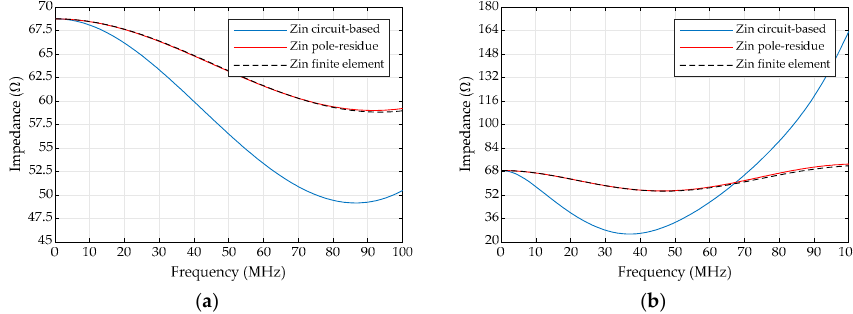
Figure 5. Impedance-frequency comparison of modelling techniques: ( a ) bus-spacer; and ( b ) 90° elbow. A close match between the pole-residue models and the finite element models implies a good fit in the frequency domain. The behaviour of the circuit-based elbow model differs significantly from both the pole-residue and finite element models. In order to validate the model in the time domain, the equivalent circuit was variously terminated by open/short circuit, a 68.7 Ω resistance (bus Z C ), a 434 Ω resistor (maximum OHL Z C ) and a capacitive-resistive termination (open disconnector 5 pF capacitor and bus Z C resistor). The validity of the pole-residue model results was assessed by comparison with the results of a transient simulation computed directly with the S-parameters in